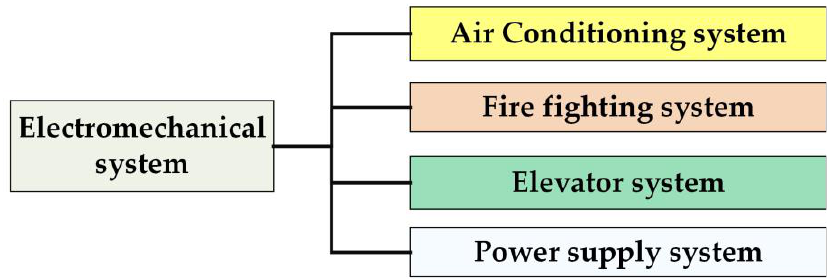
Figure 2. Schematic diagram of four subsystems of the electromechanical system of a metro company.